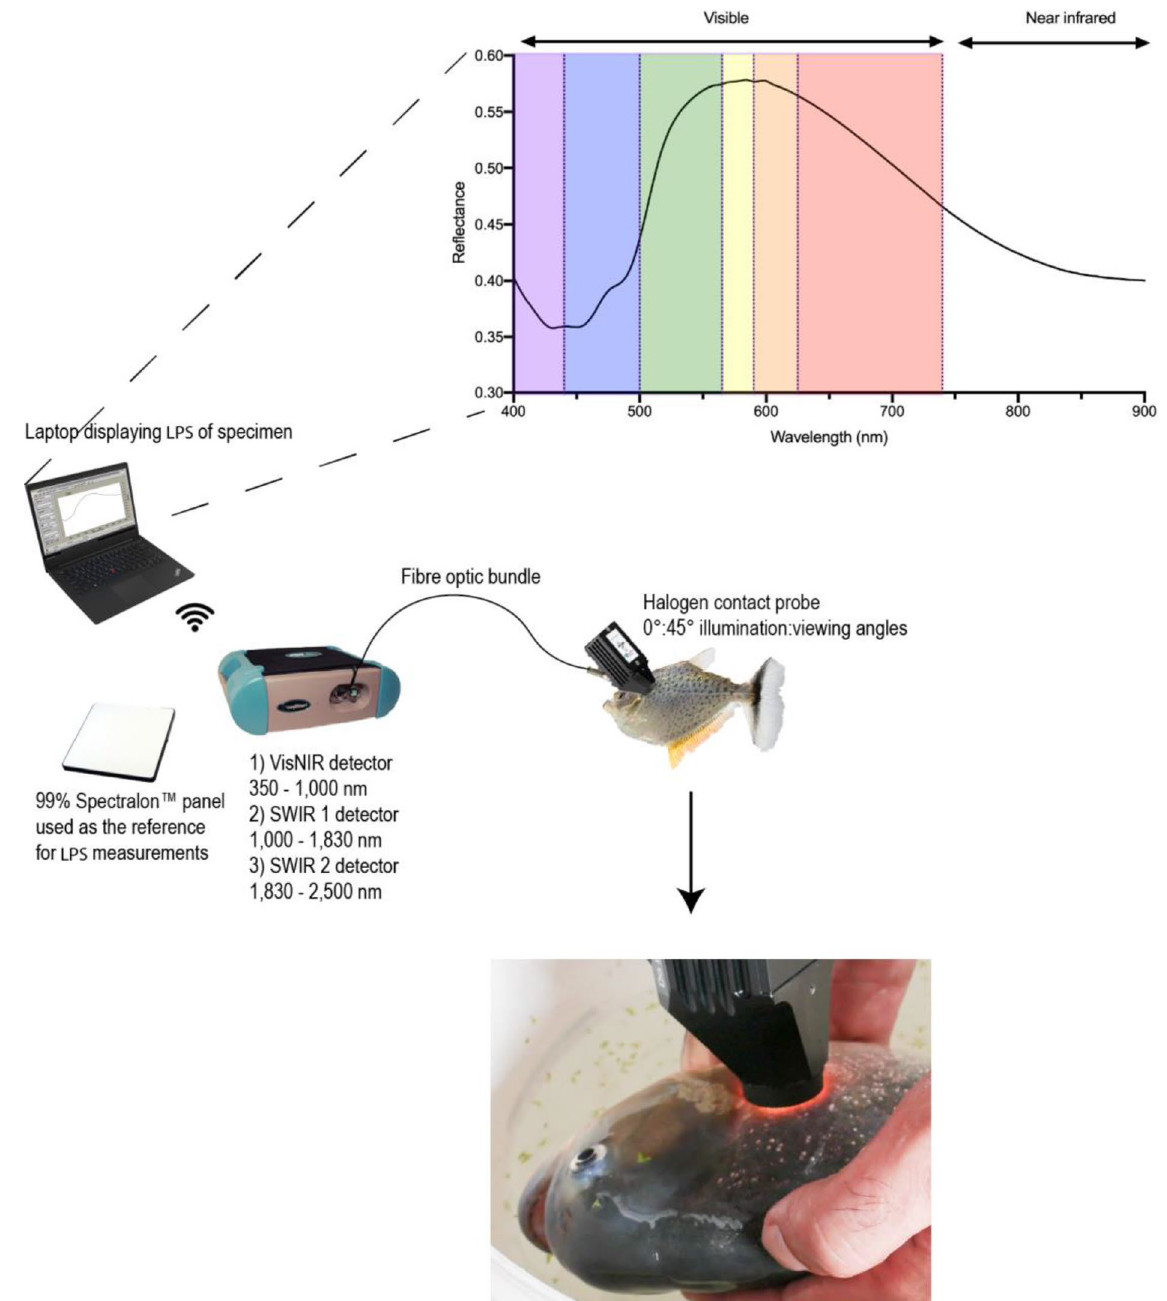
Figure 2. ASD Fieldspec 3 spectroradiometer with fish during measurement. Inset shows a typical spectral signature included in the analyses from 400 to 900 nm: the wavelength range collected by both models of spectroradiometers. The visible wavelengths are shown based on the ‘color’ they represent along with the near infrared region at longer wavelengths. Photograph shows a Pygocentrus nattereri being measured at the Laboratório de Ictiologia do IMASUL in Campo Grande,